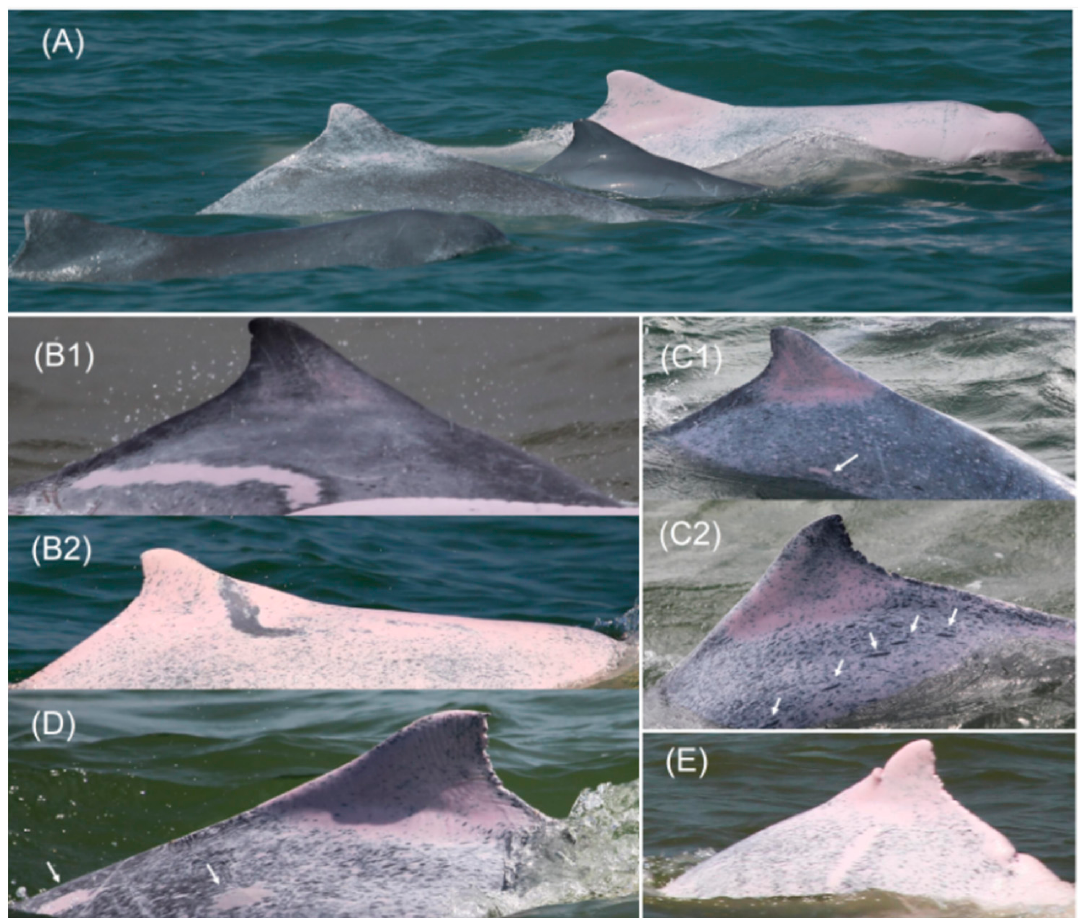
Figure 2. Typical and atypical skin coloration patterns of Indo-Pacific humpback dolphins. Typical color patterns: ( A ) life-cycle discoloration from calf to adult. Atypical color patterns: ( B1 ) hypopigmentation and ( B2 ) hyperpigmentation. Unusual, but not considered anomalous, color patterns (part of normal inter-individual variation): ( C1, C2 ) unusual white or dark spots, ( D ) merging dots, ( E ) depigmentation due to physical trauma.